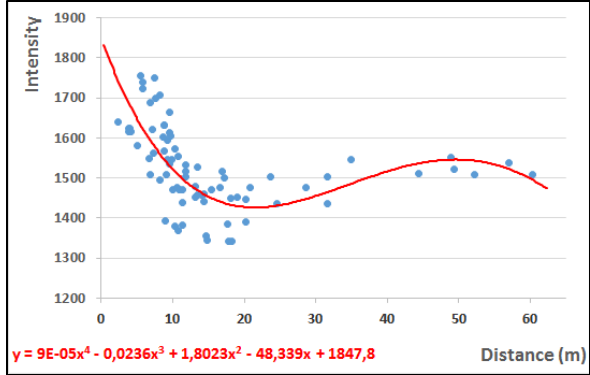
Figure 4. Polynomial interleaving of reference points and derived equation.